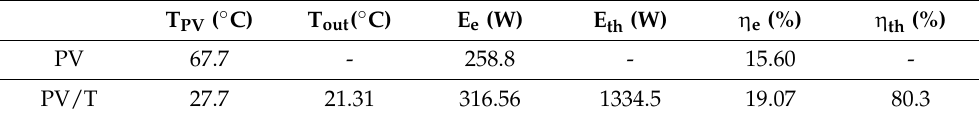
Table 4. Comparison of PV and PV/T performances at E sun = 1000 W/m 2 , T a = 35 ◦ C, and T int = 20 ◦ C.